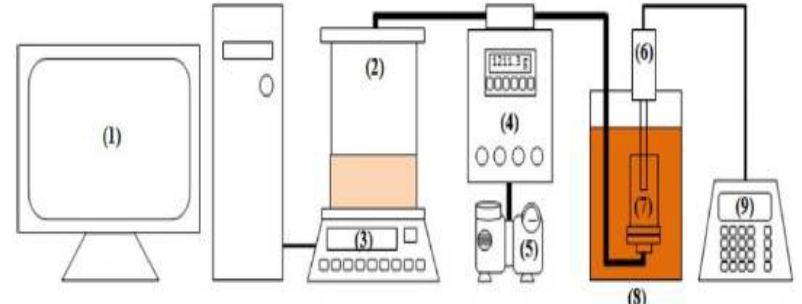
Figure 14. Ultrasonic cleaning device setup for a dead-end MF: (1) computer, (2) permeation tank, (3) electronic scale, (4) electronic controller, (5) vacuum pump, (6) ultrasonic probe, (7) support membrane, (8) power box, and (9) ultrasonic controller [105].